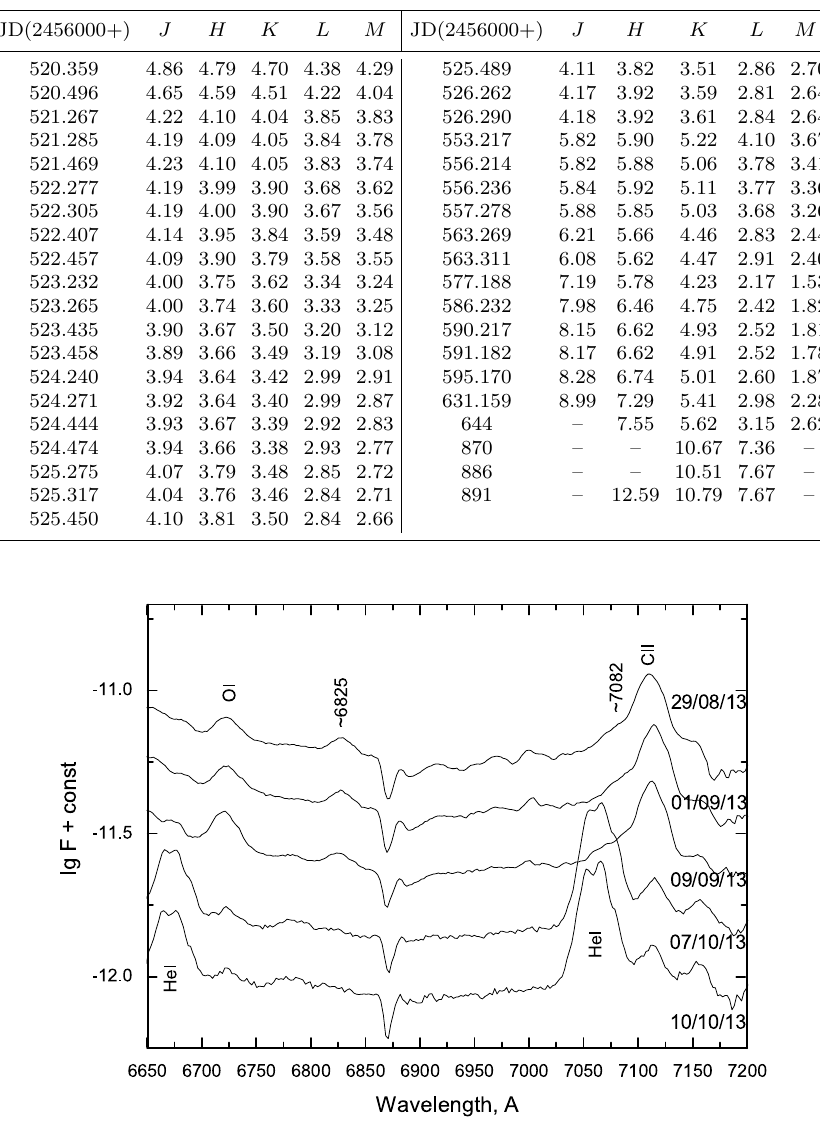
Fig. 4. A broad emission detail feature near (cid:21) = 6825